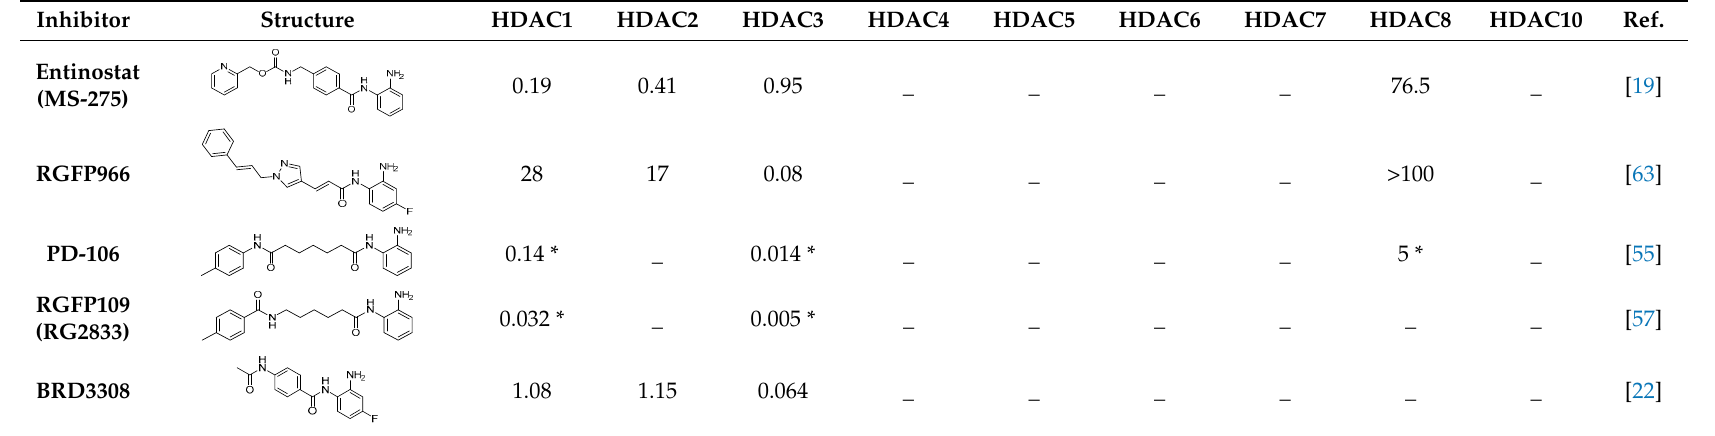
Table 2. The structures of HDAC inhibitors with HDAC IC 50 or K i values in µ M.